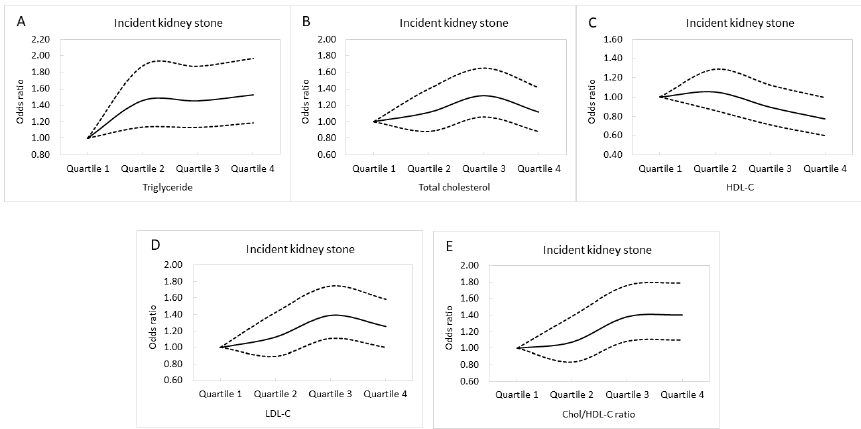
Figure 3. The adjusted curves of incident kidney stone disease among the quartiles of triglyceride ( A ), total cholesterol ( B ), HDL-C ( C ), LDL-C ( D ), and Chol/HDL-C ( E ). HDL-C, high-density lipoprotein cholesterol; LDL-C, low-density lipoprotein cholesterol; Chol/HDL-C, the ratio of total cholesterol to HDL-C. Dashed lines mean odds ratio. Solid lines mean 95% confidence interval.